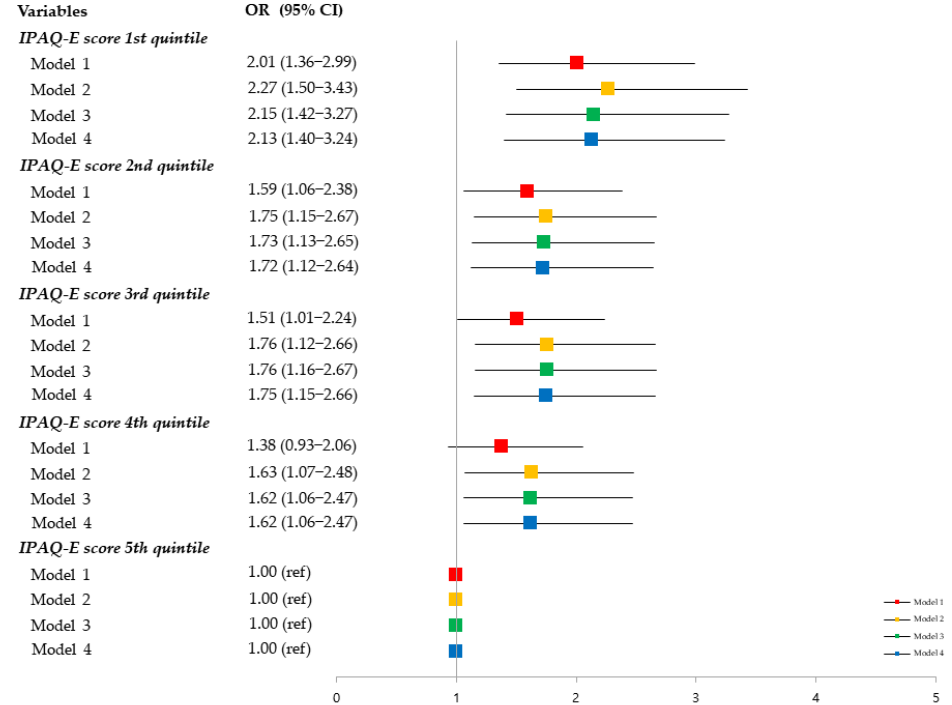
Figure 2. Adjusted odds ratios (ORs) and 95% confidence intervals (CIs) of the IPAQ-E score quintiles for sarcopenia. Model 1: Adjusted for sociodemographic variables (age, sex, education, living alone, marital status, and social security recipient) and DXA equipment used. Model 2: Further adjusted for health-related lifestyle variables (smoking status, alcohol consumption, number of comorbidities, nutritional status, low physical activity, and body mass index). Model 3: Further adjust for psychosocial variables (depressive symptoms and cognitive function). Model 4: Further adjusted for social variables (participation in social